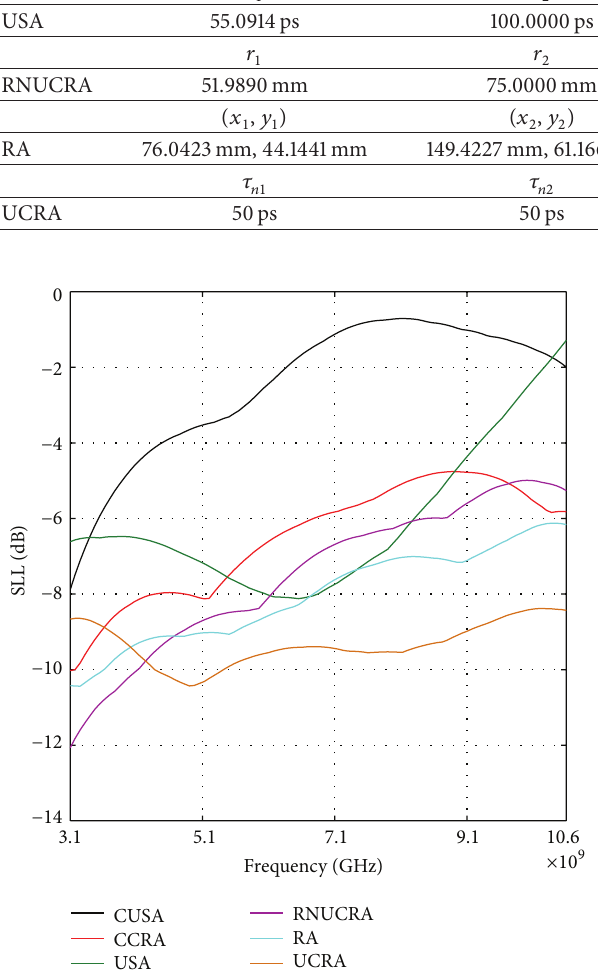
Figure 9: SLL values for the TDTD arrays in the frequency.